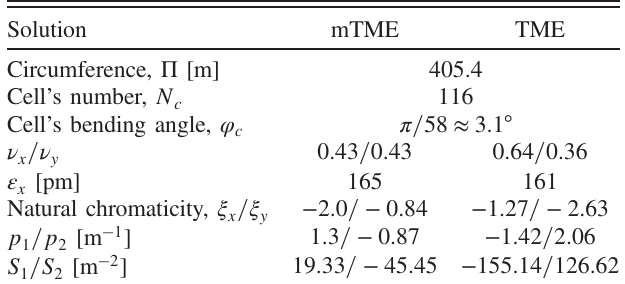
TABLE II. Main parameters of the model cells mTME and TME.